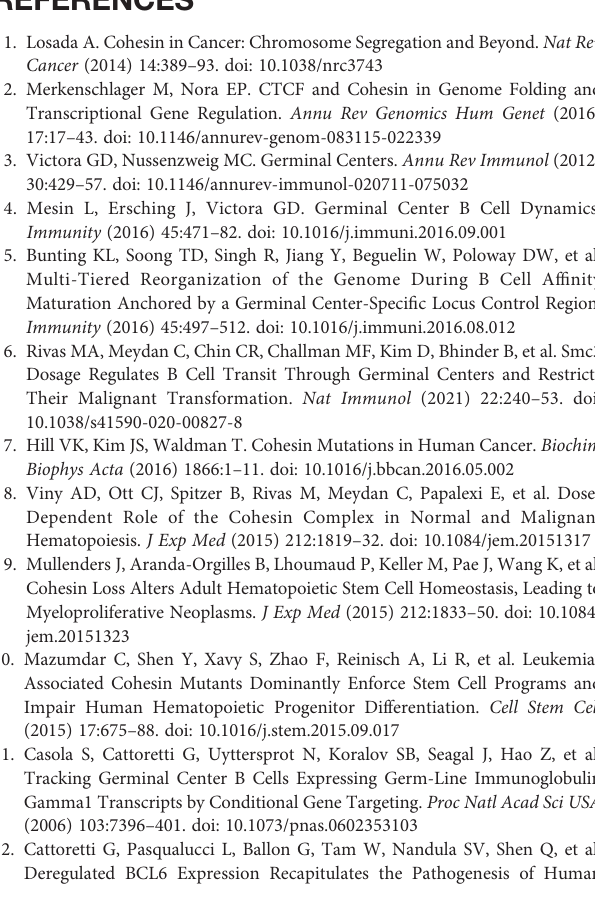
Supplementary Figure 3 | Smc3 haploinsuf fi cient cells undergo proliferation burst but fail to differentiate into plasma cells. UMAP depicting cell lineage from CB ! PC. Supplementary Figure 4 | Smc3 haploinsuf fi ciency increases DNA damage in germinal center B cells. (A) Gating strategy used to detect phospho- g H2AX by fl ow